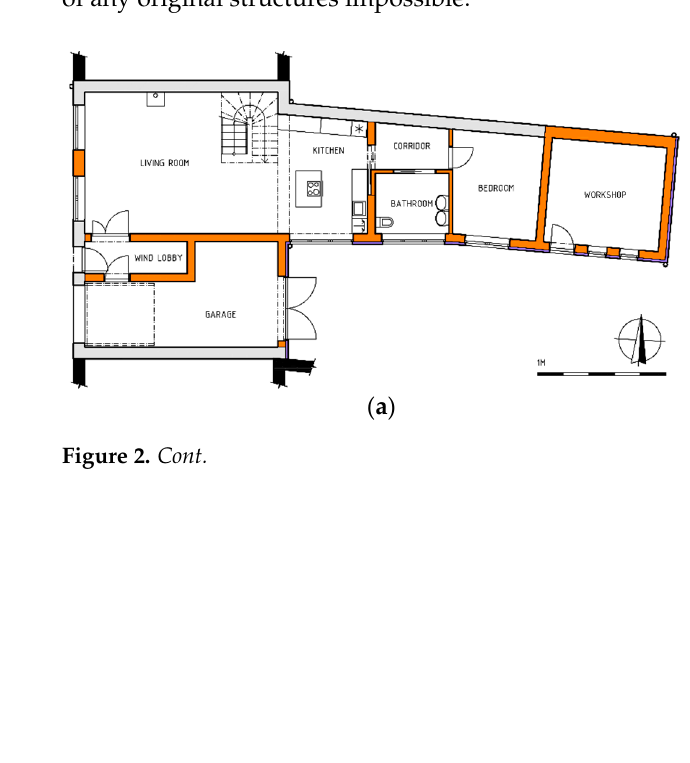
Figure 1. Original terraced house evaluated in V-1 LCA: ( a ) southern elevation with black hatching indicating envelope of adjacent house; ( b ) ground floor plan with coloured hatching indicating dif- ferent construction materials identified during surveys. Black = envelope walls of adjacent houses, red = solid fired ceramic bricks, blue = aerated concrete blocks, red-yellow stripes = mix of solid fired bricks and adobe bricks, red-orange stripes = mix of solid fired bricks and hollow ceramic bricks.